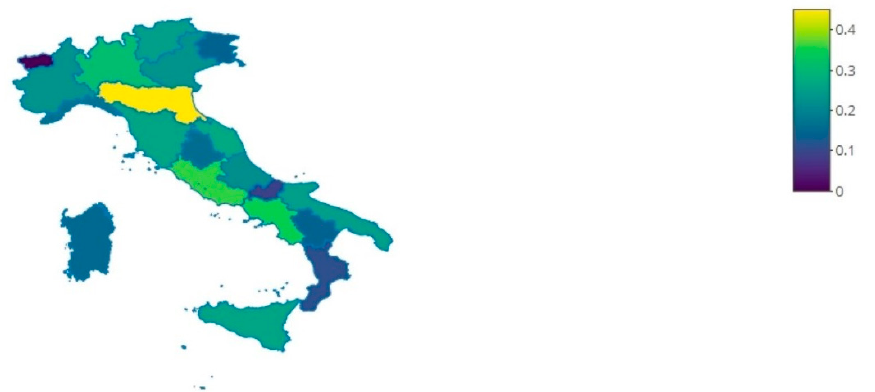
Figure 1. Choropleth map in which the color intensity of the region is relative to the percentage of hospitals that have a Facebook profile.